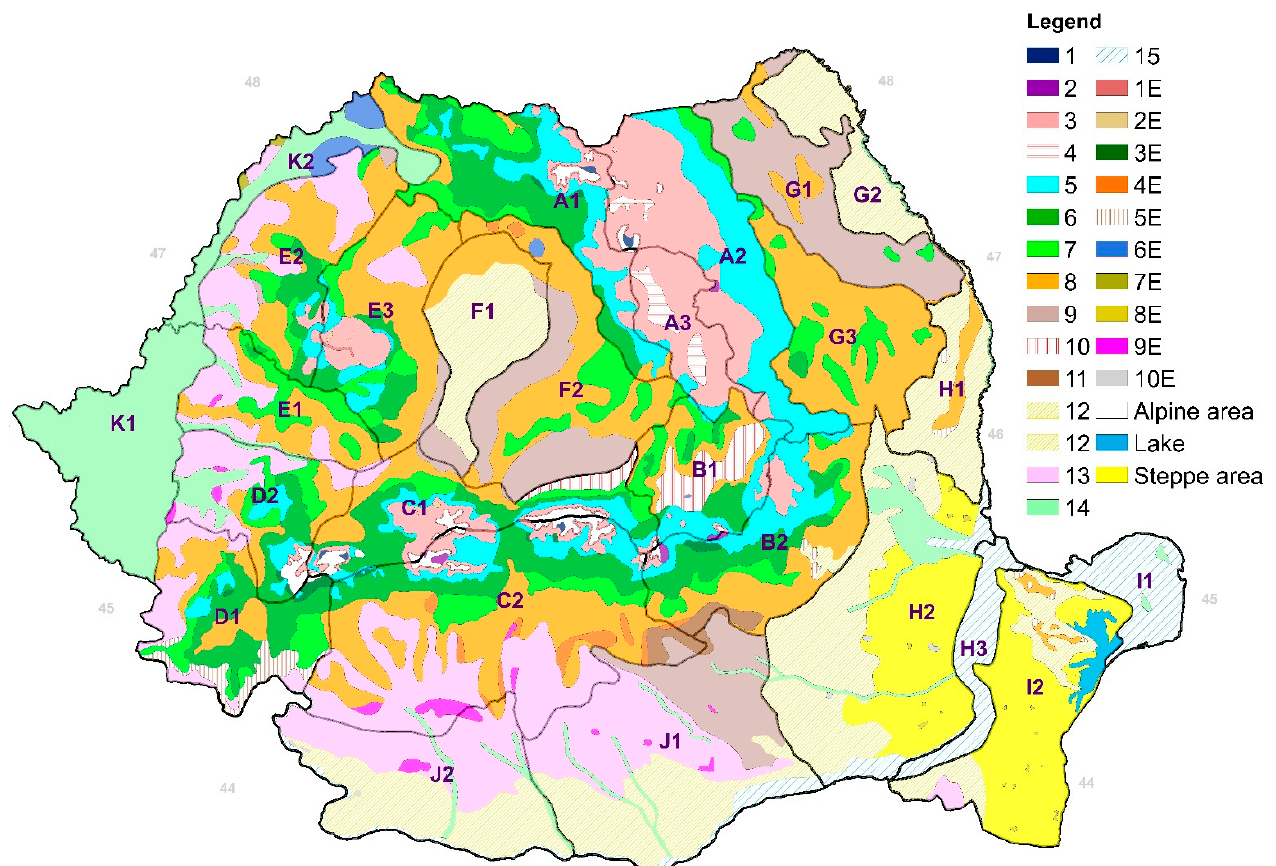
Figure 1. The map of provenance regions in Romania (as defined in [30]): A1: Eastern Carpathians, western cline; A2: Eastern Carpathians, eastern cline; A3: Giurgeu–Ciuc depression; B1: Bra ș ov depression; B2: Curvature Carpathians, outer cline; C1: Southern Carpathians, northern cline; C2: Southern Carpathians, southern cline; D1: Mehedin ț i/Cerna/Semenic Mountains; D2: Ț arcu/Poiana